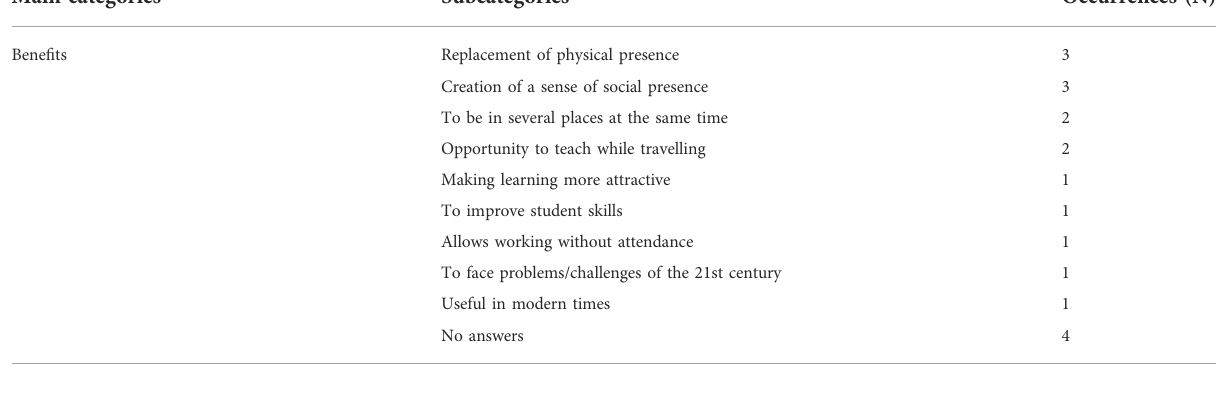
TABLE 5 Opportunities of